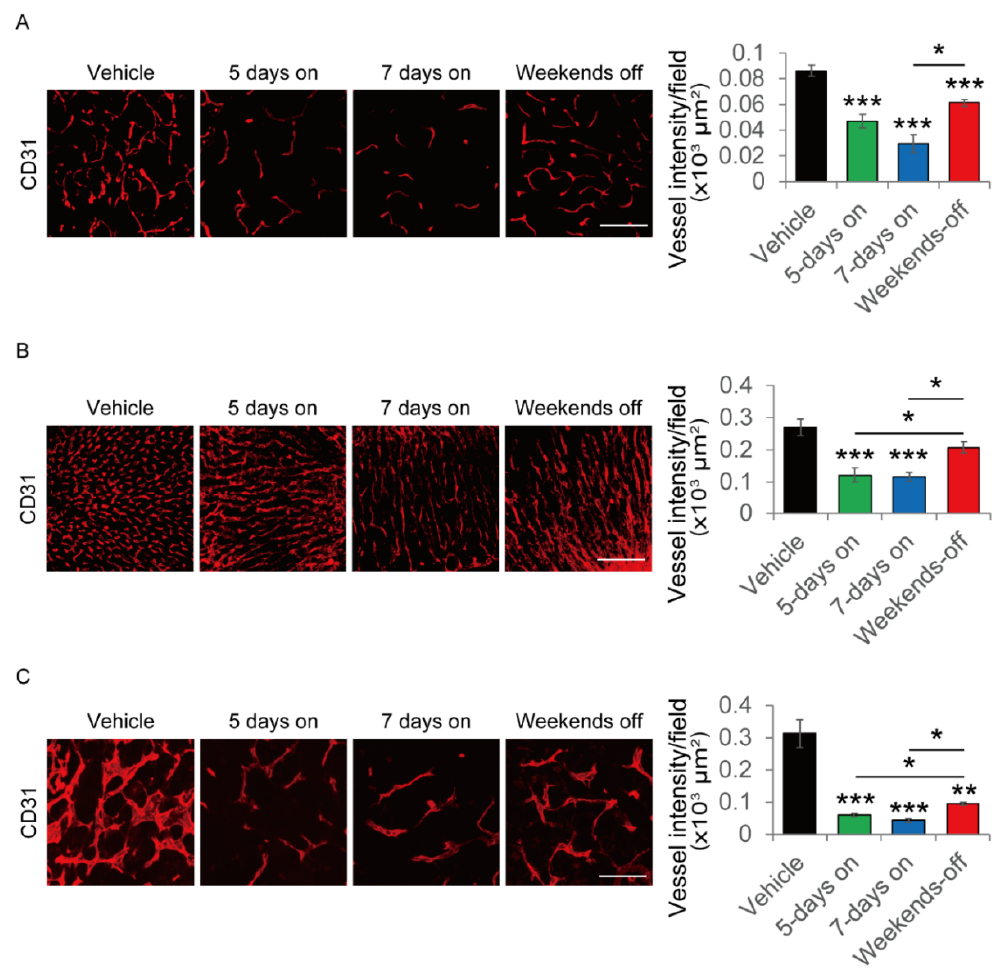
Figure 5. Assessment of vascular change in the weekends-off method of lenvatinib administration in the mouse hepatoma orthotopic model. ( A ) Vascular change in the thyroid. Quantification of CD31+ tumor vessels (six random field from three independent tumor samples per group). ( B ) Vascular change in the adrenal glands. Quantification of CD31+ tumor vessels (six random field from three independent tumor samples per group). ( C ) Vascular change in the tumor. Quantification of CD31+ tumor vessels (six random field from three independent tumor samples per group). Bar represents 200 μm. * p < 0.05, ** p < 0.01, *** p < 0.001. Data are presented as means ± SEM. SEM: standard error of the mean.